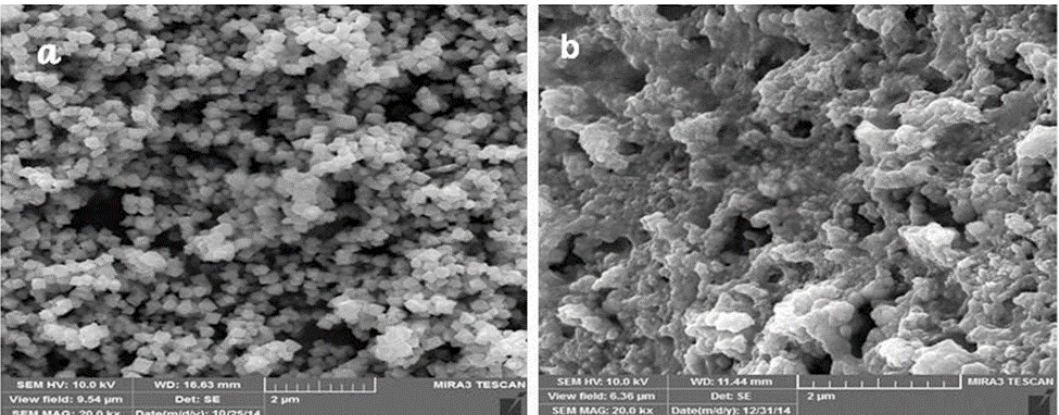
Fig. 7: SEM images of magnetic nanoparticles (40.0 kx) (a) SEM images of Cisplatin-encapsulated magnetic nanoparticles modified with PCL-PEG copolymer